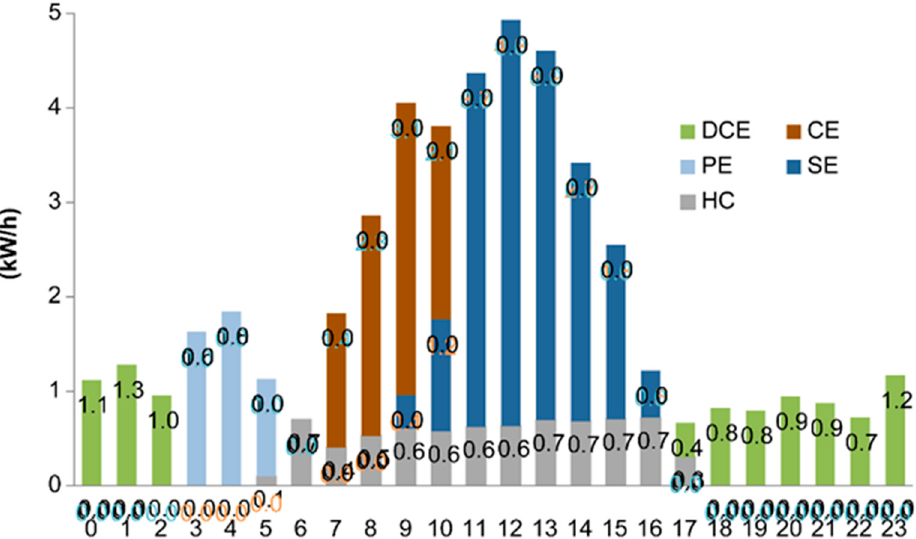
Figure 12. Hourly energy balance for PV8 SB (L) in August 2020.